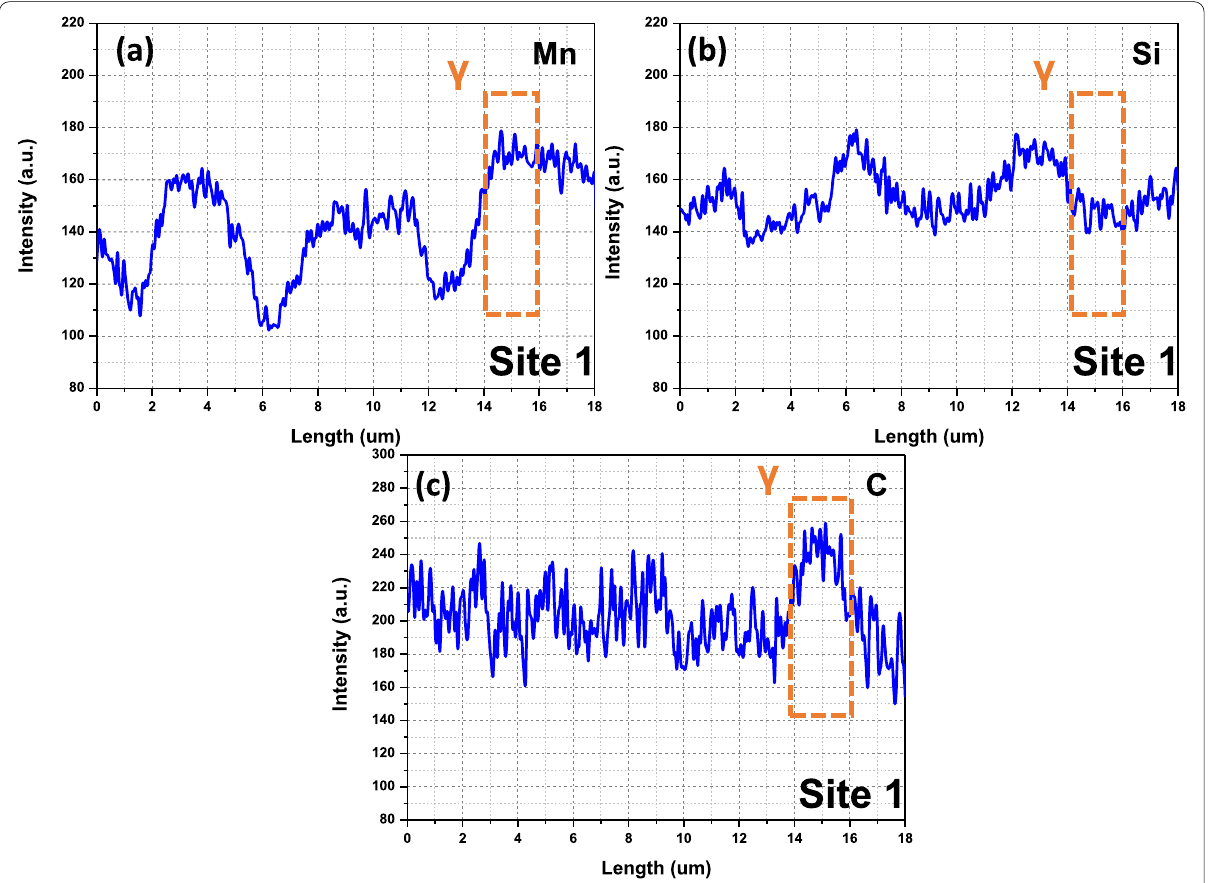
Fig. 9 Extracted intensity profiles from site 1 in Fig. 7c to